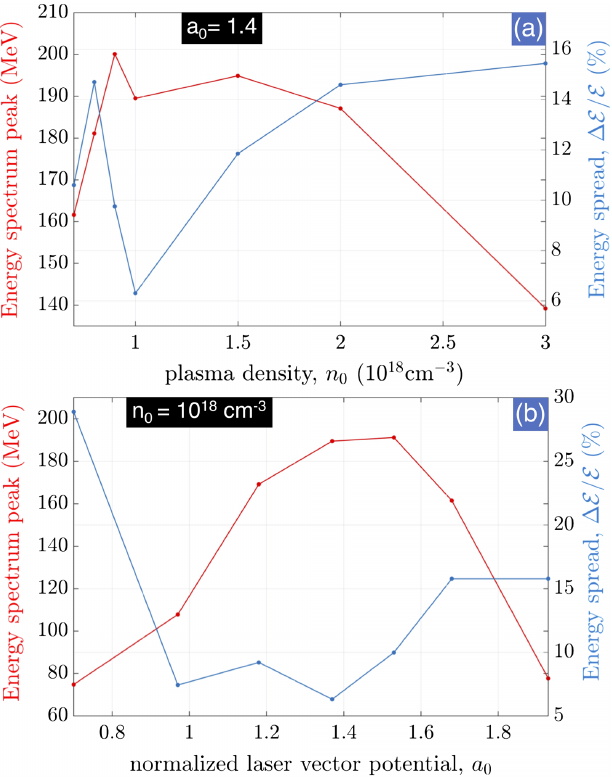
FIG. 3. Energy spectral characteristics of Scheme-A e þ -beam from PIC simulations varied with n 0 in (a) and a 0 in